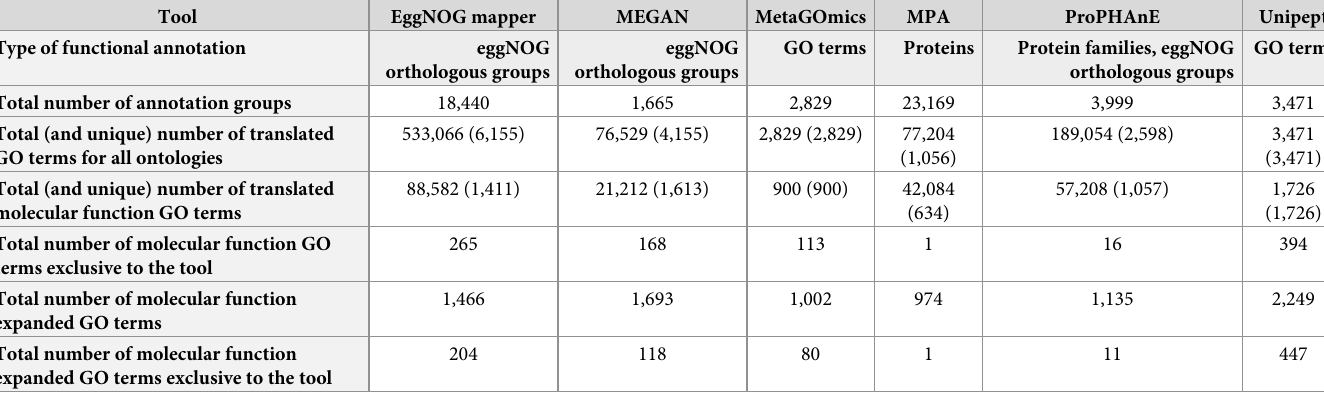
Table 1. Functional analysis of the oral dysbiosis dataset using molecular function GO terms.